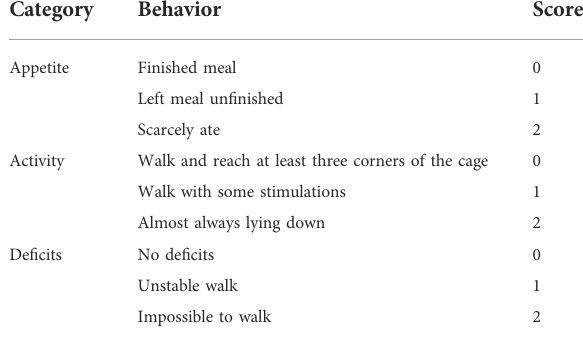
TABLE 1 Neurobehavioral